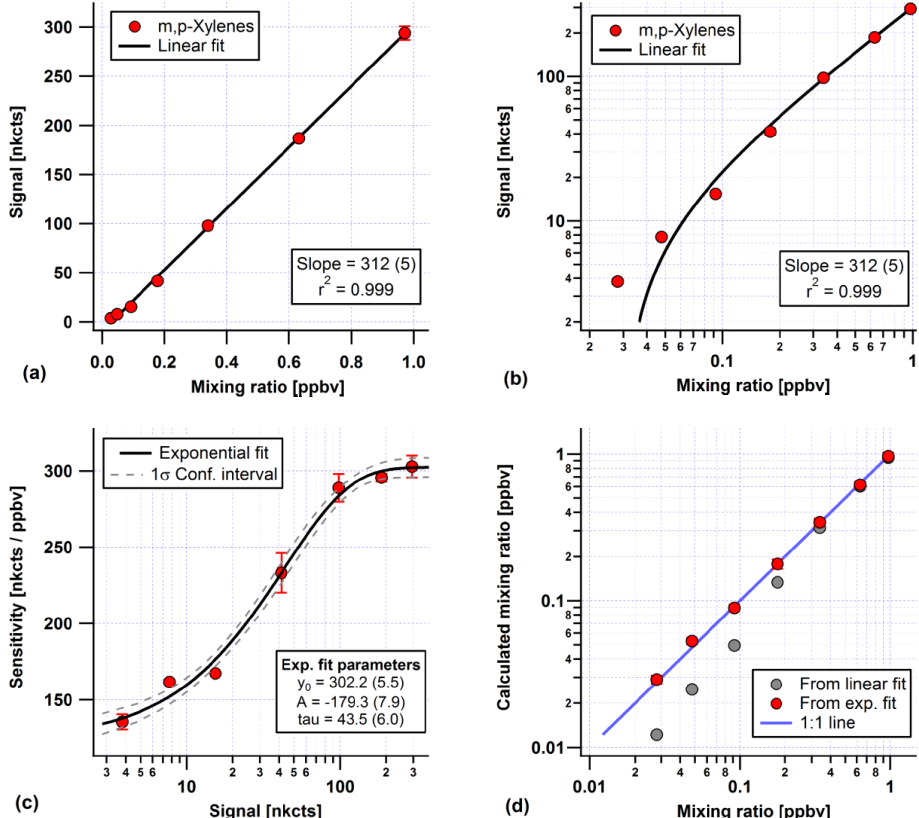
Figure 5. Example nonlinear sensitivity calibration for m, p-xylenes. Panels (a) and (b) show a linear fit of normalized signal versus mixing ratio for a seven-point calibration, using linear and log scaling of the same data. In panel (c) an exponential function has been fit to sensitivity calculated at each calibration point versus normalized counts. Panel (d) shows mixing ratio calculated from both the linear fit and the exponential fit of sensitivity plotted against actual mixing ratio. Values in parentheses are 1 σ uncertainties of fit